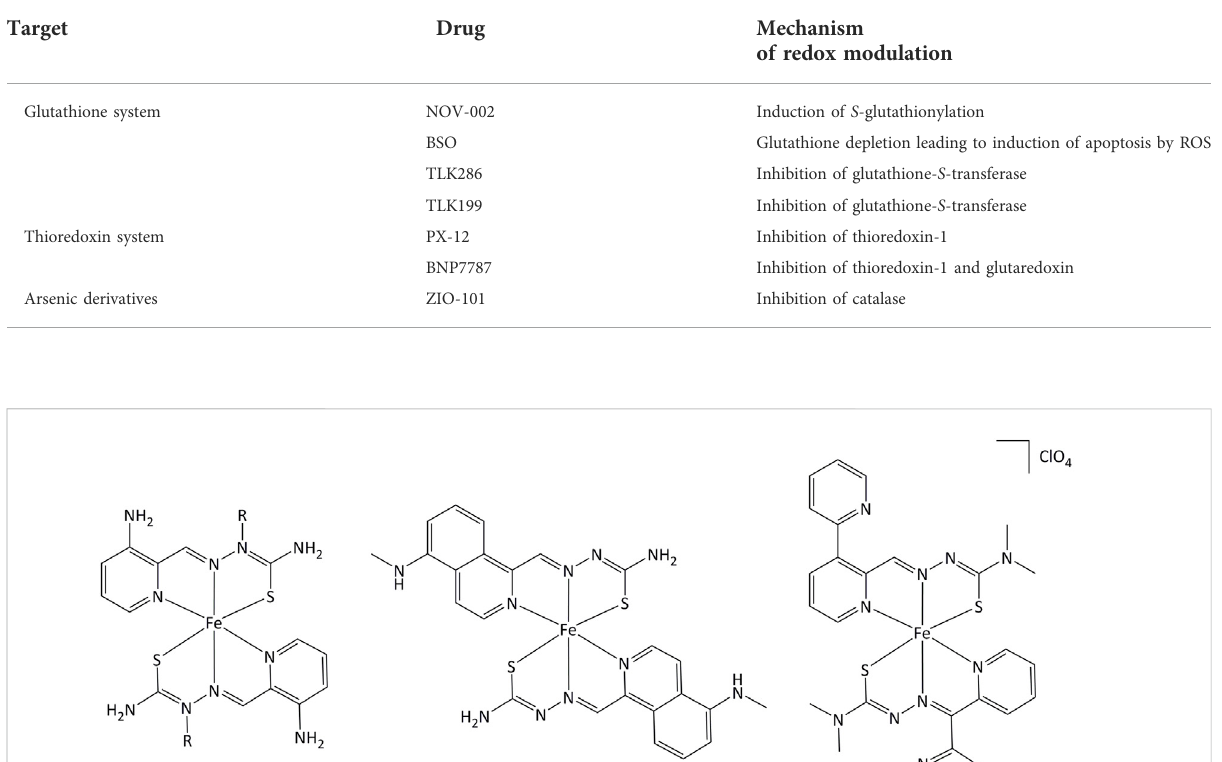
TABLE 1 Redox modulation by cytotoxic anticancer drugs currently used clinically (Chen and Chang, 2019).